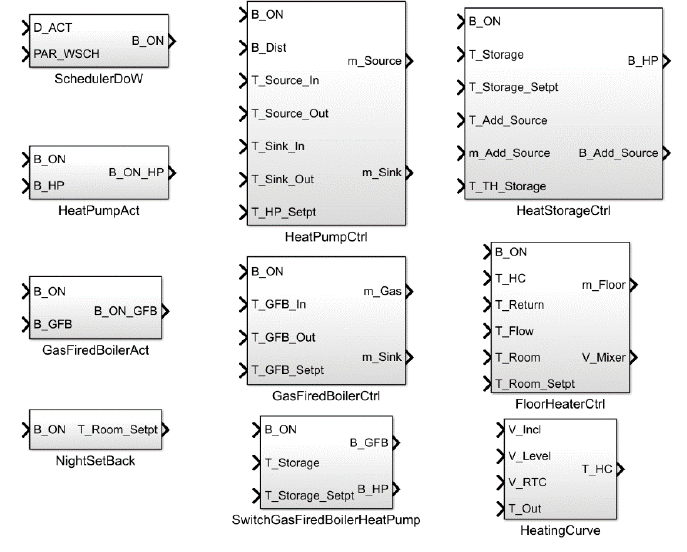
Figure 2. Developed SIMULINK blocks for different types of heating.